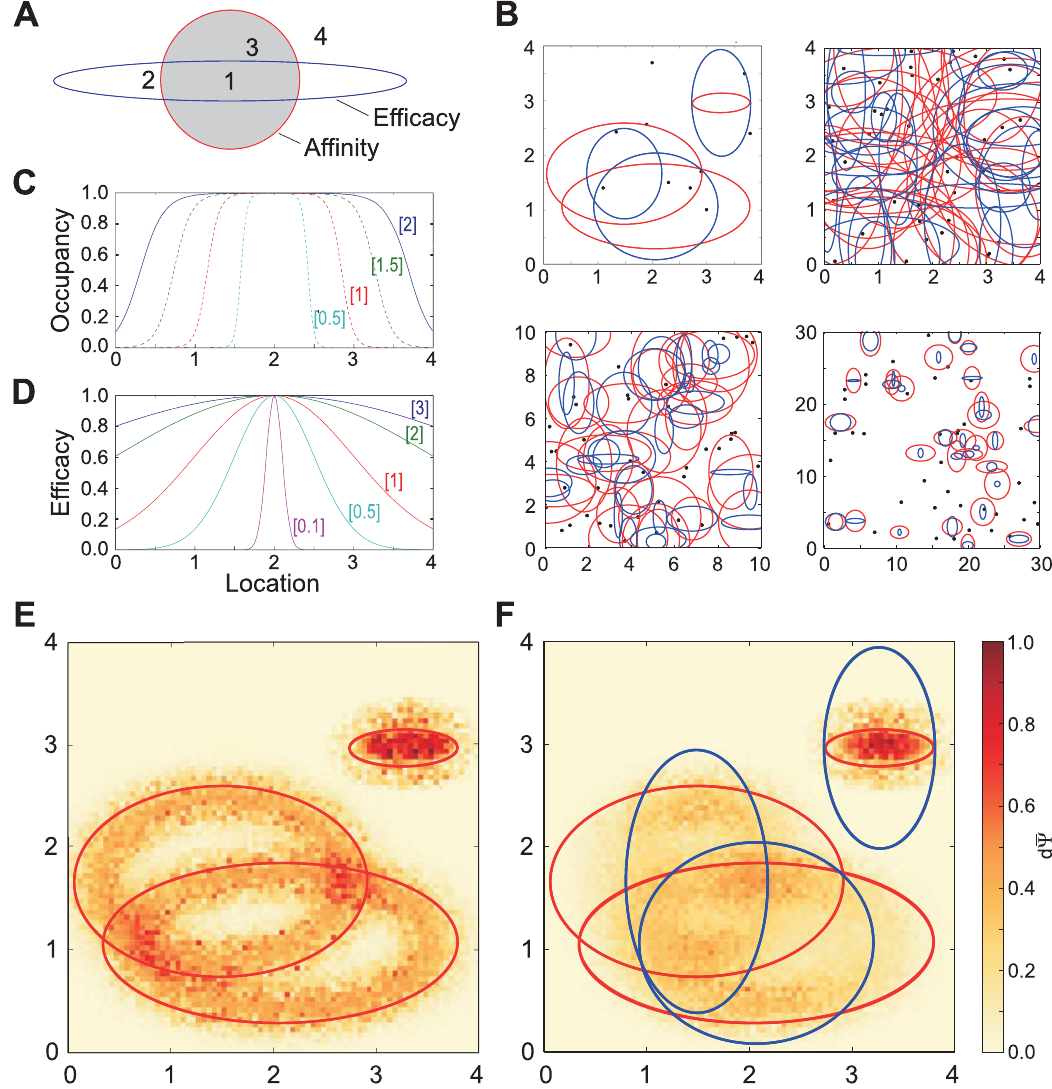
Fig 1. Model parameterization. A. Illustration of how the relationship between the affinity and efficacy Gaussians generates diverse ligand-receptor binding and activation properties. Red (affinity) and blue (efficacy) ellipses denote the contour line marking two standard deviations (2.0 σ ) from the Gaussian peak in a two-dimensional Q-space. 1 , Strong agonist (high affinity, high efficacy). 2 , Weak agonist (low affinity, high efficacy). 3 , Partial agonist or antagonist (high affinity, low efficacy). 4 , Weakly binding or insensitive (low affinity, low efficacy). B. Illustrations of receptor and ligand distributions randomly deployed from uniform distributions into two-dimensional Q-spaces of different sizes. Pairs of Gaussian contour lines (1.5 σ ) centered on the same point denote the affinity (red) and efficacy (blue) Gaussians of individual receptors. Receptor standard deviations were drawn from uniform distributions of 0.5 to 1.5 q-units (affinity) and 0.05 to 1.0 q-units (efficacy; standard parameters). Black dots denote ligand points. Top left , A [4,4] Q-space containing four receptors and ten ligand points. Top right , A [4,4] Q-space containing 30 receptors and 40 ligand points. Bottom left , A [10,10] Q-space containing 30 receptors and 40 ligand points. Bottom right , A [30,30] Q-space containing 30 receptors and 40 ligand points. C. Effects of affinity Gaussian breadth on receptor occupancy. In a one-dimensional Q-space of range [4] containing a single receptor centered at location 2.0, with an affinity Gaussian exhibiting a standard deviation of 0.5, 1, 1.5, or 2 q-units and a fixed efficacy of unity, the receptor occupancy was calculated for 400 points distributed along the abscissa. Peak affinity was K d = 10 − 8 M, asymptotic affinity was K d = 10 +2 M, and ligand concentration was 10 − 5 M (standard parameters). Occupancy fell off rapidly between about 0.7 and 1.0 standard deviations from the mean of the underlying affinity Gaussian. Bracketed numbers denote the standard deviation of the affinity Gaussian. D. Effects of the breadths of receptor efficacy Gaussians. Standard deviations of 0.1, 0.5, 1.0, 2.0, and 3.0 q-units are illustrated. Efficacy fell off most rapidly between roughly 0.5 and 2.0 standard deviations from the mean of the efficacy Gaussian. Bracketed numbers denote the standard deviation of the efficacy Gaussian. E. Heatmaps depicting d � C � values per location in Q-space, with three receptors deployed and efficacy held